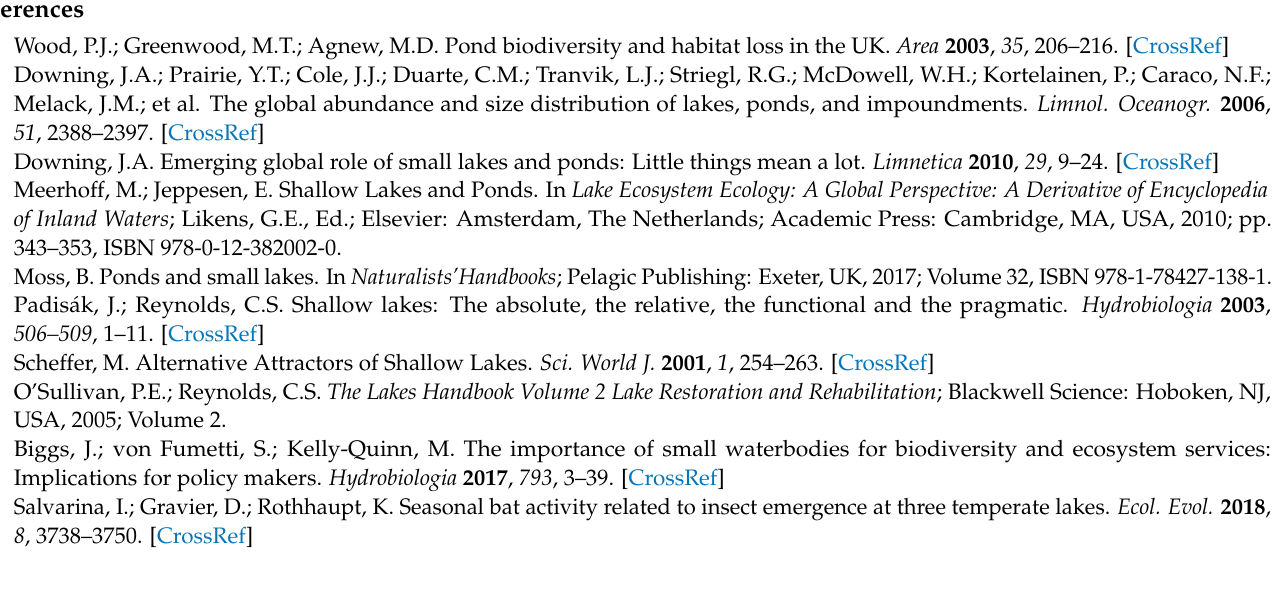
analysis Indval performed on the 4 groups obtained with cluster partition from abundance-based taxonomic matrix. Table S3: complete results of the correlation analysis between environmental parameters floristic richness and diversity